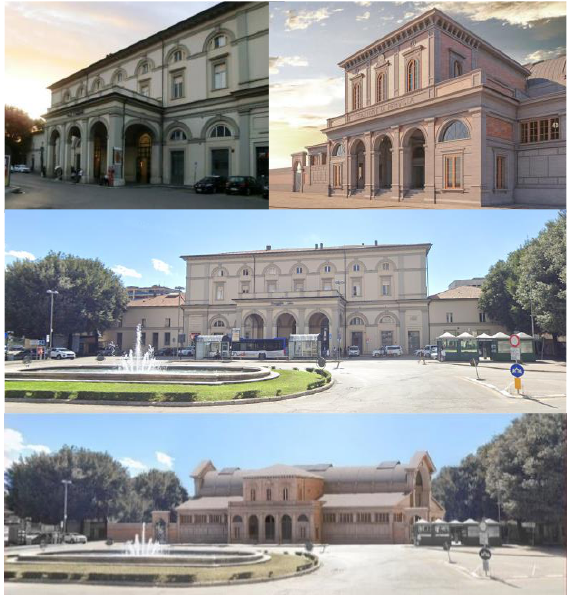
Figure 3. mook-up image of unrealized